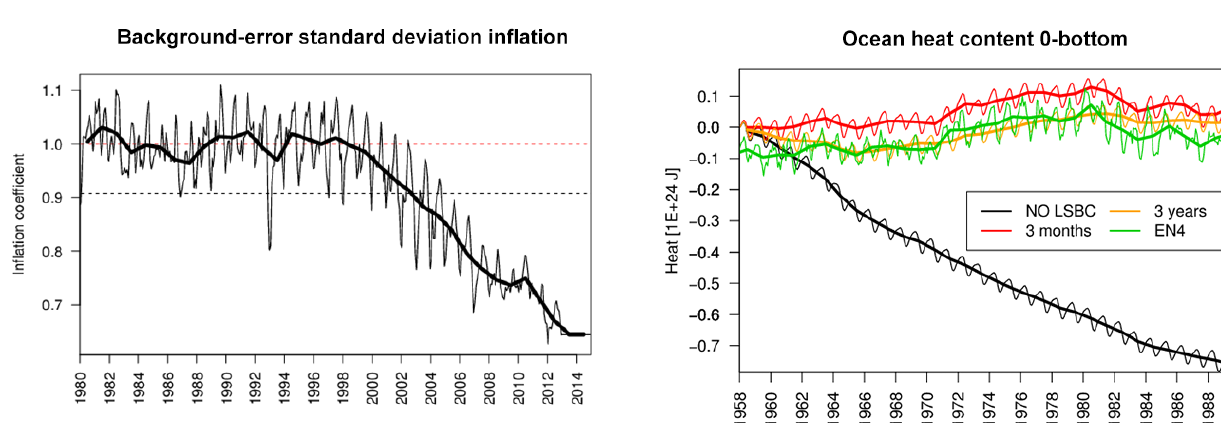
Figure 4. Total ocean heat content in a set of preliminary experi- ments during 1958–1990 performed to test the impact of the large- scale bias correction (LSBC) timescale. Thin lines refer to monthly means and thick lines to yearly means. Black lines refer to the ex- periment without LSBC; red and orange lines to the experiment with LSBC and with a timescale of 3 months and 3 years, respec- tively. Also shown is the heat content computed from the UK Met Office EN4 dataset (Good et al.,